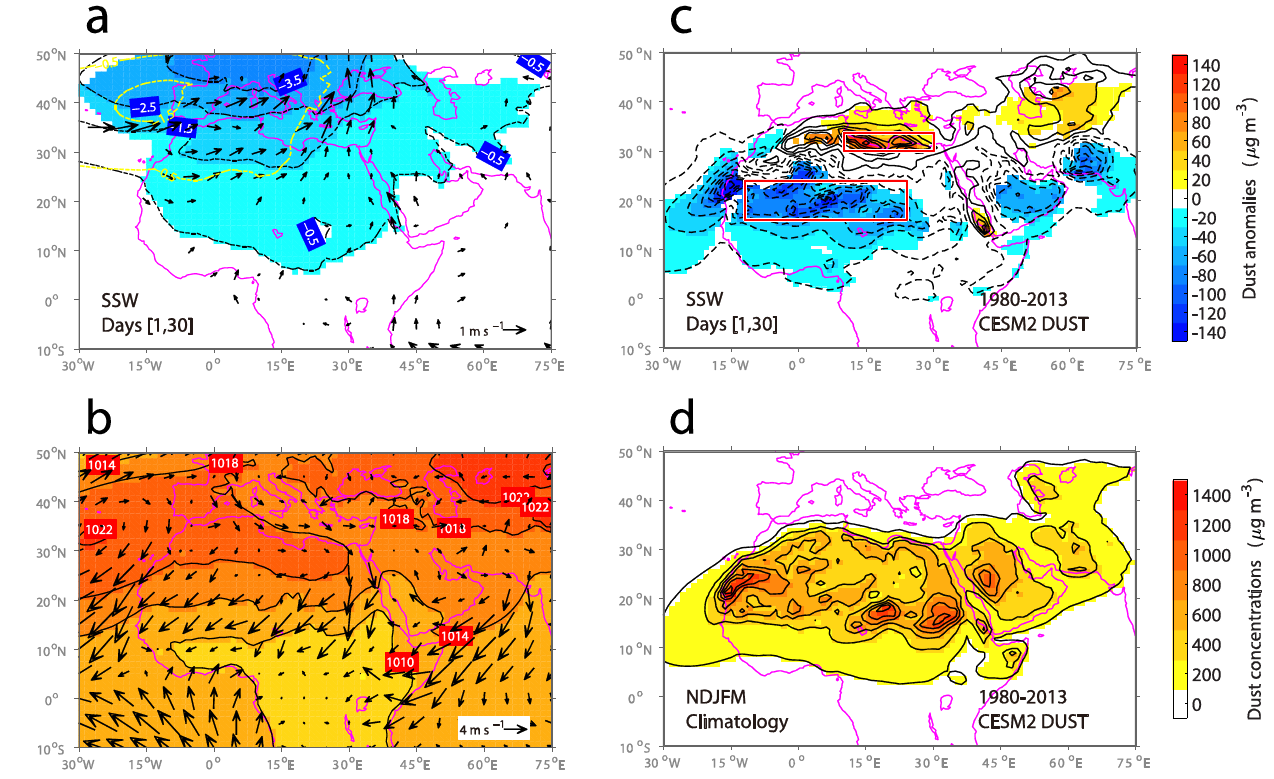
Fig. 1 | Large-scale meteorological and dust response to sudden stratospheric warming events (SSWs). a Composites of anomalous sea level pressure (SLP) (contours) and 10m wind (arrows) during SSW episodes over the 1980/81-2013/14 extendedwinters(fromNovembertoMarch,NDJFM).TheSLPand10mwind fi elds come from the MERRA2 reanalysis. Shadings indicate SLP anomalies that are sta- tistically signi fi cant at the p <0.10 level based on a two-tailed Monte Carlo test. Wind vectorsshown arestatisticallysigni fi cantatleastforonecomponent. Scaling for the wind vectors is given in the bottom-right corner (units: ms − 1 ). Yellow con- toursindicate the regressedSLP anomaliesonto the extended wintertime(NDJFM) North Atlantic Oscillation (NAO) index (see Methods). To make them comparable